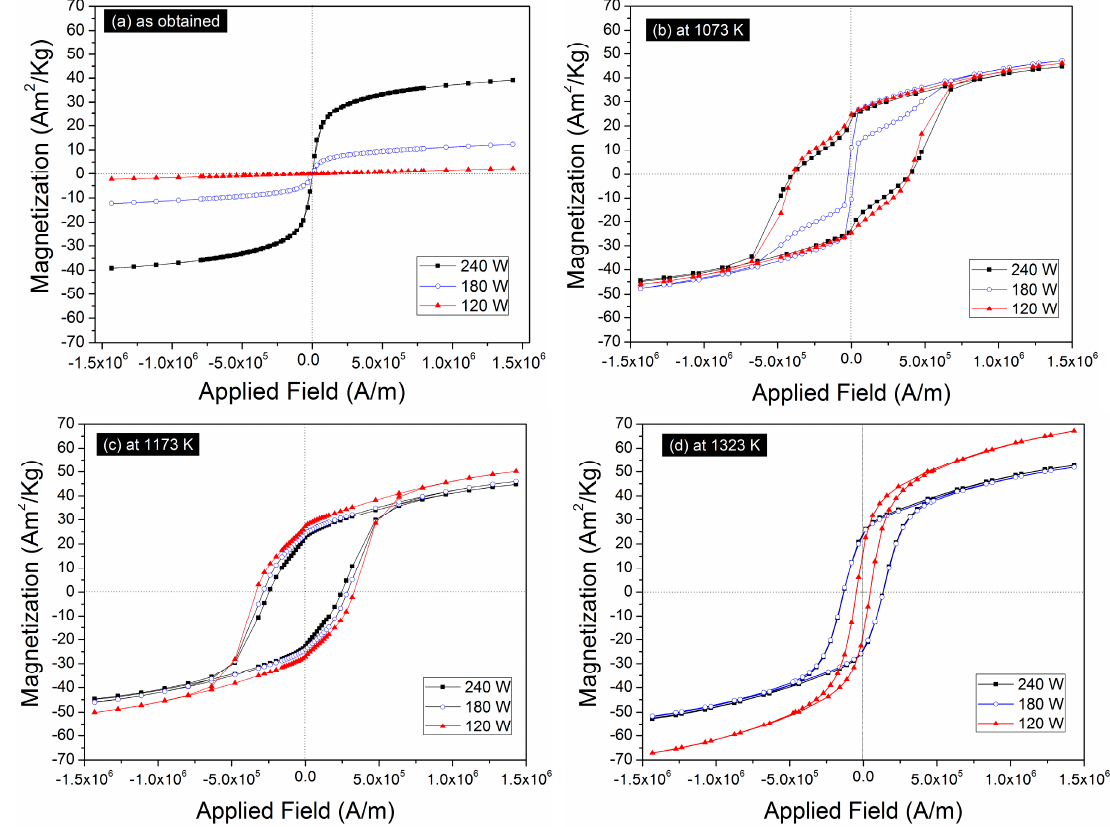
Figure 7. Magnetic hysteresis cycles powders obtained by sonochemistry at 120, 180, and 240 W of SOP for 3 h. ( a ) Without annealing; ( b ) With annealing at 1073 K; ( c ) With annealing at 1173 K; and ( d ) With annealing at 1323 K.